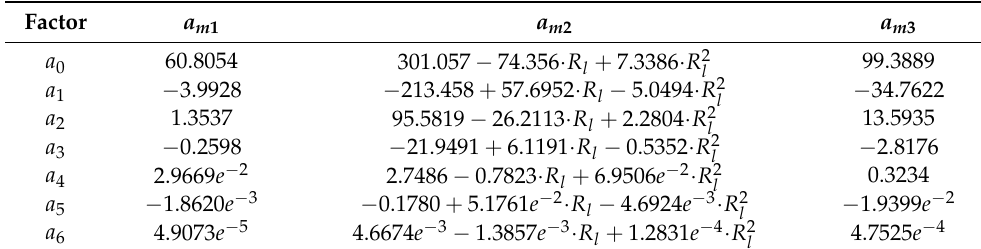
Table 1. Values of polynomial a m coefficients.